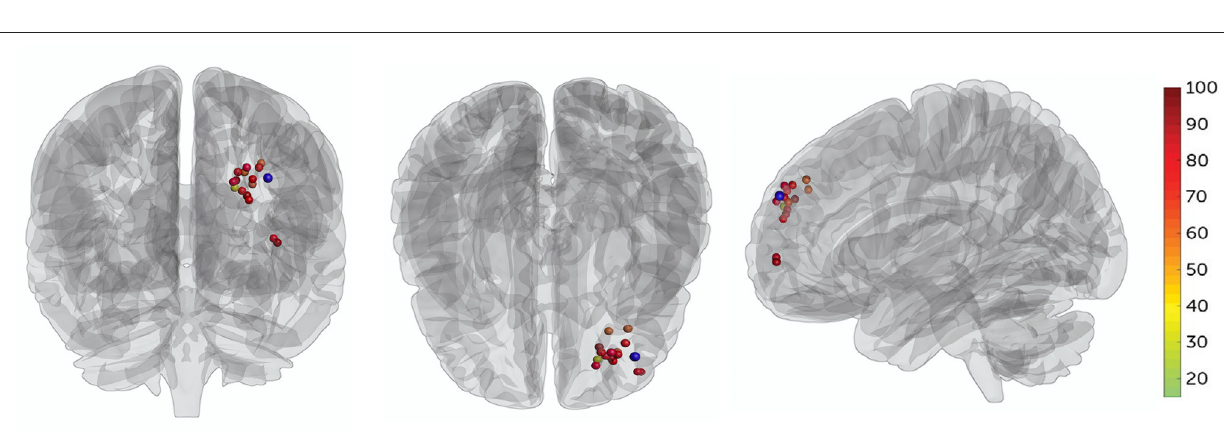
= 3.5 × 3.5 × 4.0 mm 3 . During the scan, all participants